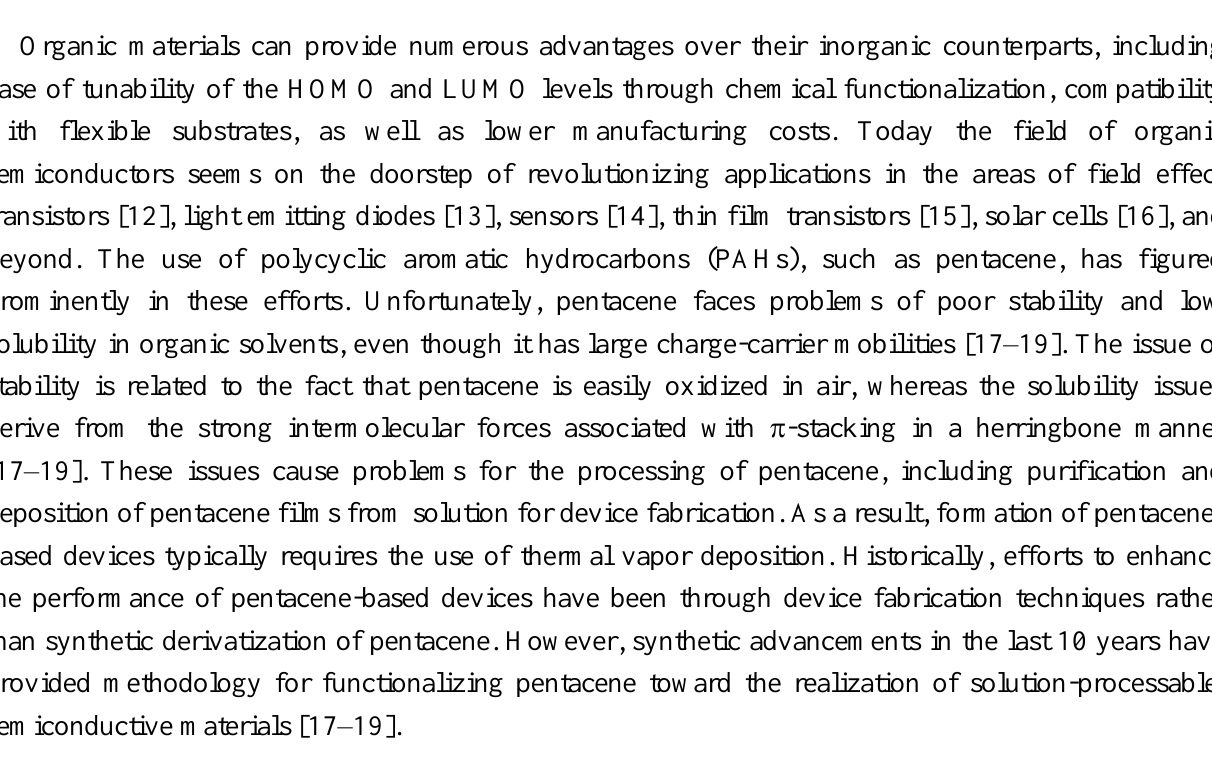
Figure 1. Structure of 6,13-bis(triisopropylsilylethynyl)pentacene ( 1 ).